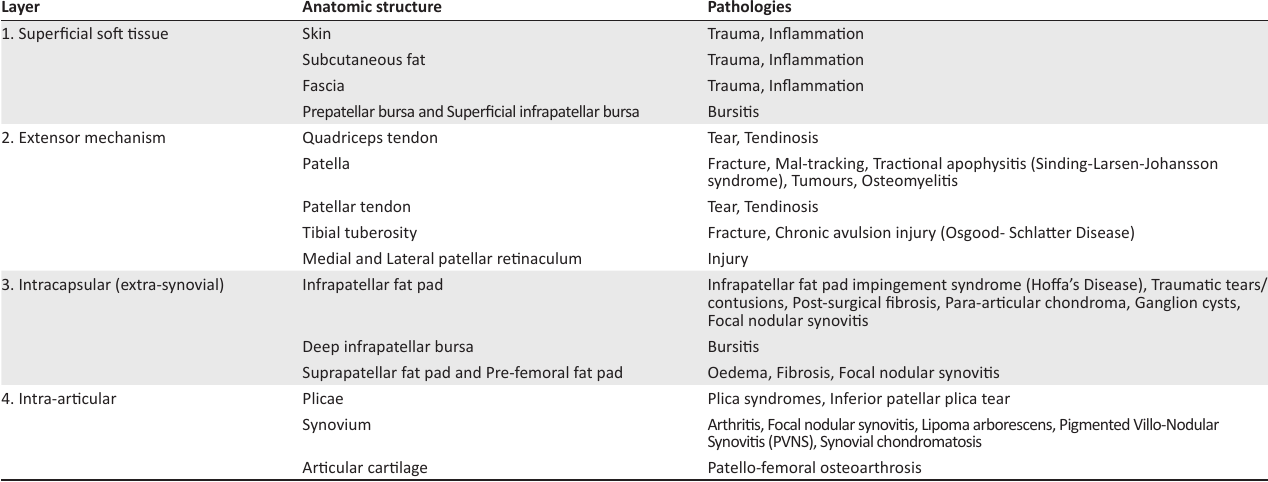
FIG URE 3: Magnetic resonance imaging of a normal infrapatellar plica: oblique sagittal T2WI (a) and oblique sagittal PDFS image (b) demonstrating the normal infrapatellar plica (arrow head) as a thin low-signal intensity structure within Hoffa’s fat pad, inserting into the inferior pole of TABLE 1: Spatial approach to anterior knee pain. 6 Layer